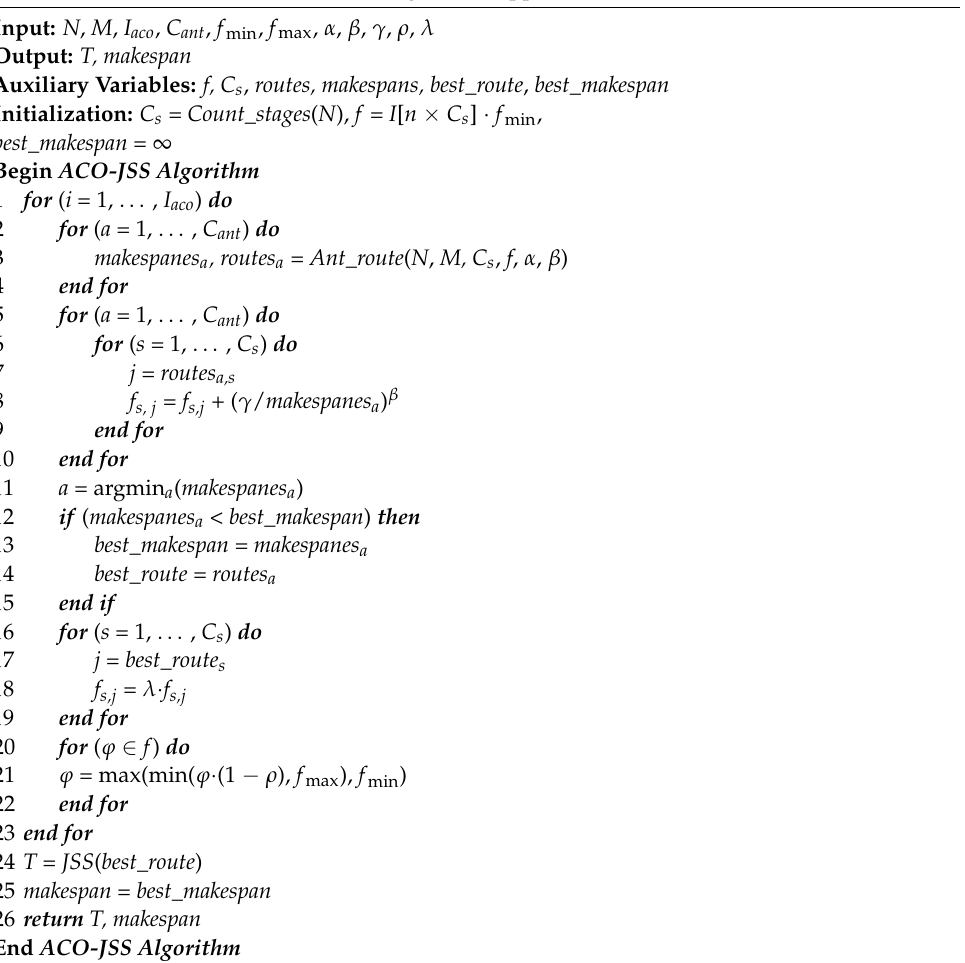
Algorithm 1. Pseudocode for the ACO Algorithm Application for JSS